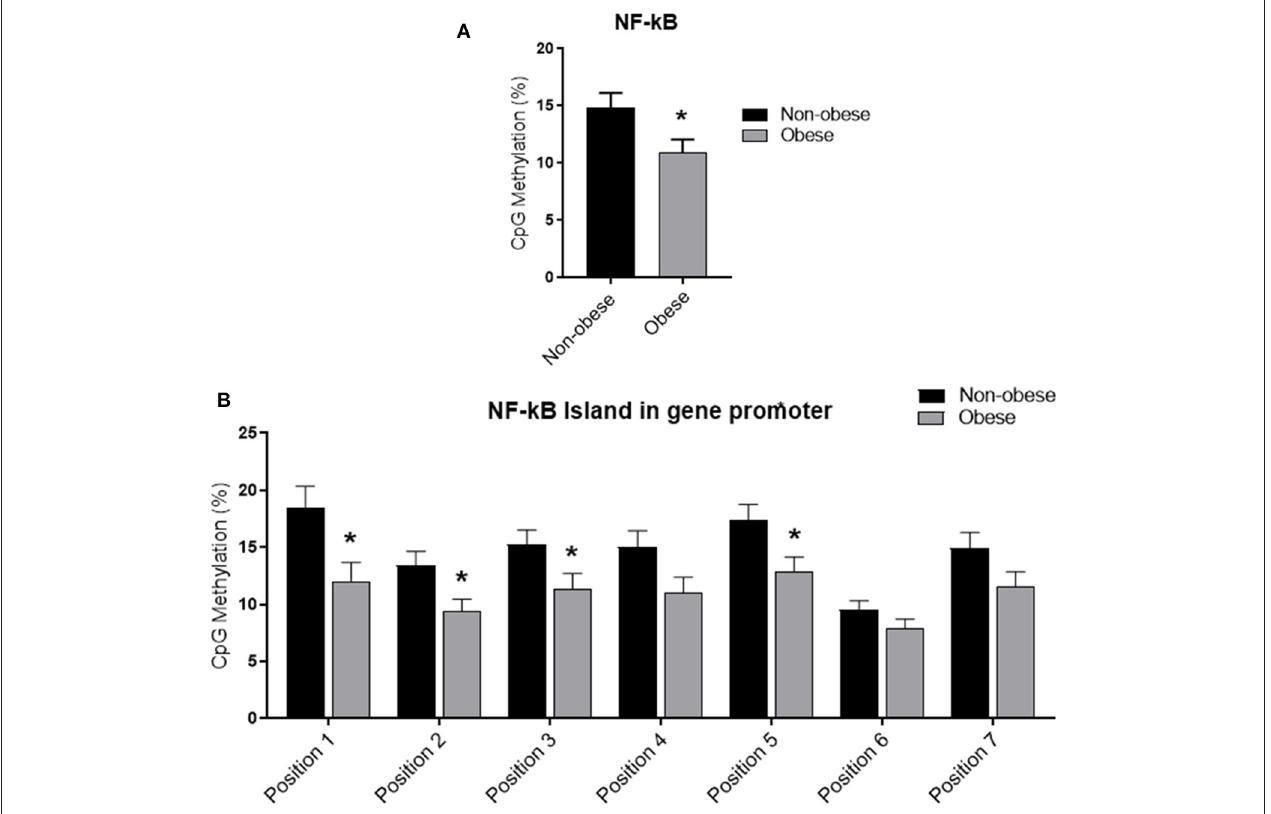
FIGURE 2 | Methylation analysis of NF-kB promoter in obese and non-obese subjects (A) Schematic representation of CpG site locations in human NF-kB promoter. (B) The DNA methylation status was expressed as percentage of CpGs methylation. Data are mean ± Standard Errors. * p < 0.05 vs. non-obese subjects.